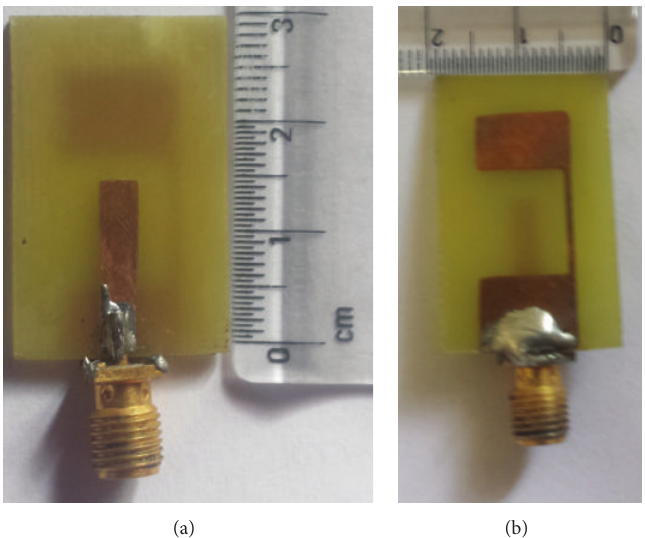
Figure 8: A photograph of the proposed dual-band monopole antenna. (a) Front view. (b) Back view.